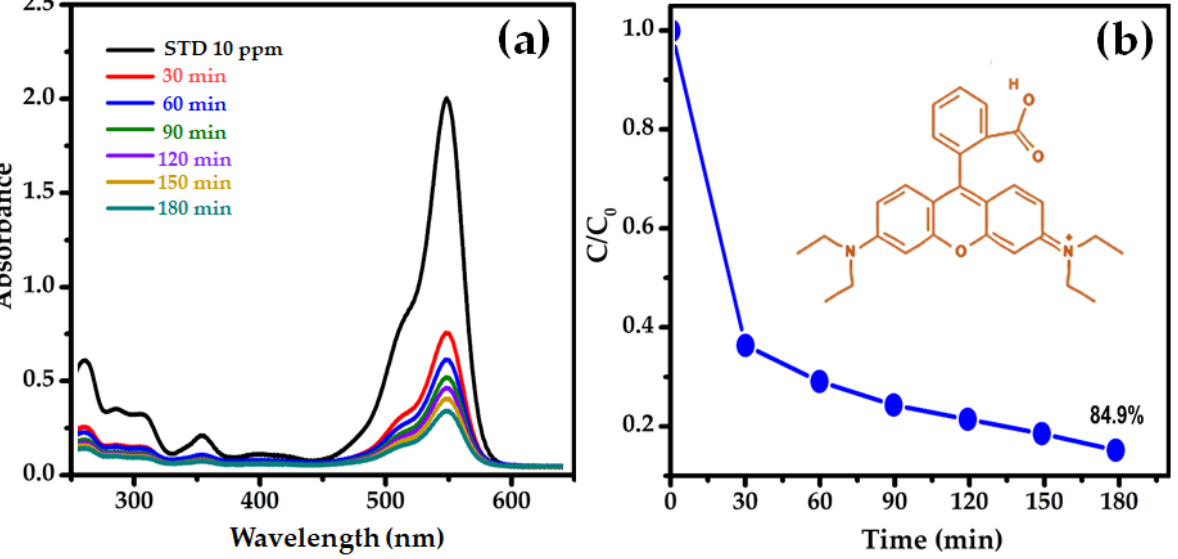
Figure 5. ( a ) Absorbance spectra of the RhB in aqueous solution at different reaction times and ( b ) degradation of the RhB solution over SnS 2 nanoparticles.